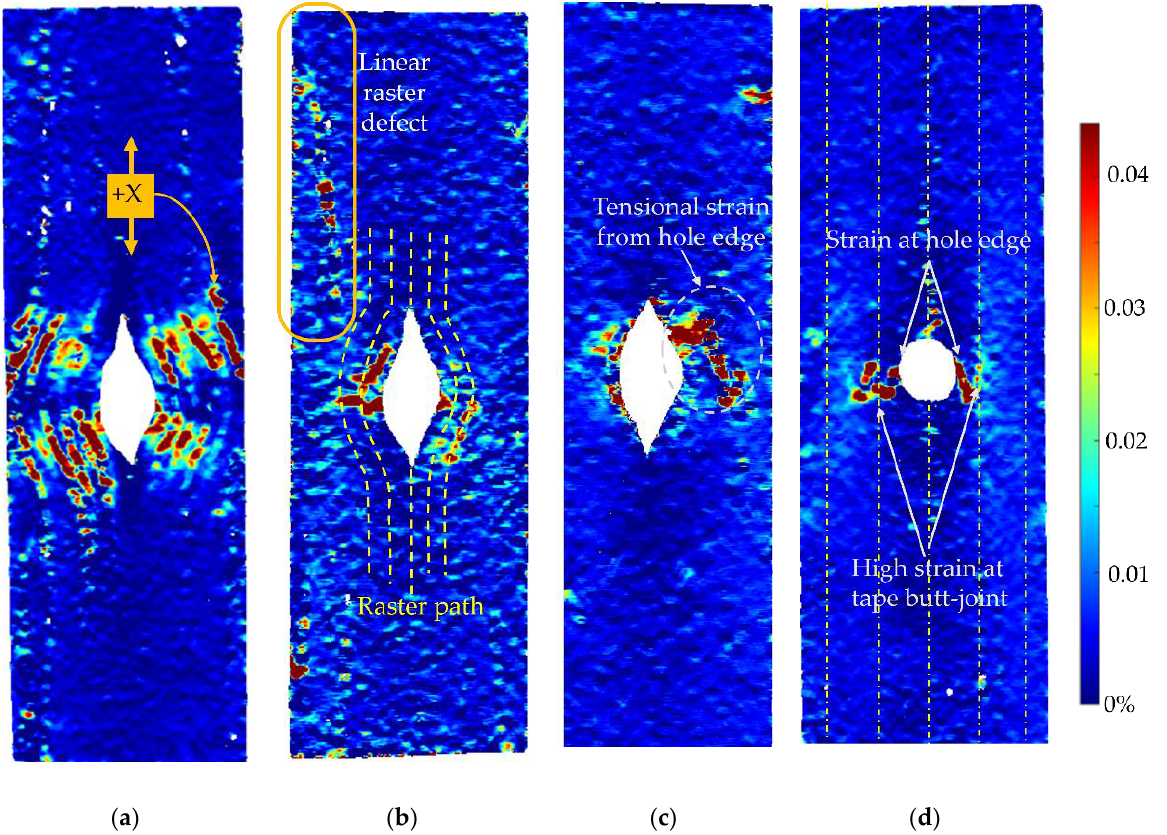
Figure 12. DIC analysis of longitudinal strain ( ε x ) at the maximum load of each sample in different types: ( a ) printed 10C at 59.77 MPa; ( b ) 4C at 100.5 MPa; ( c ) 4C-Oven at 159.2 MPa (post-printing consolidated part); ( d ) tapes at 166.4 MPa (layup part with a punched